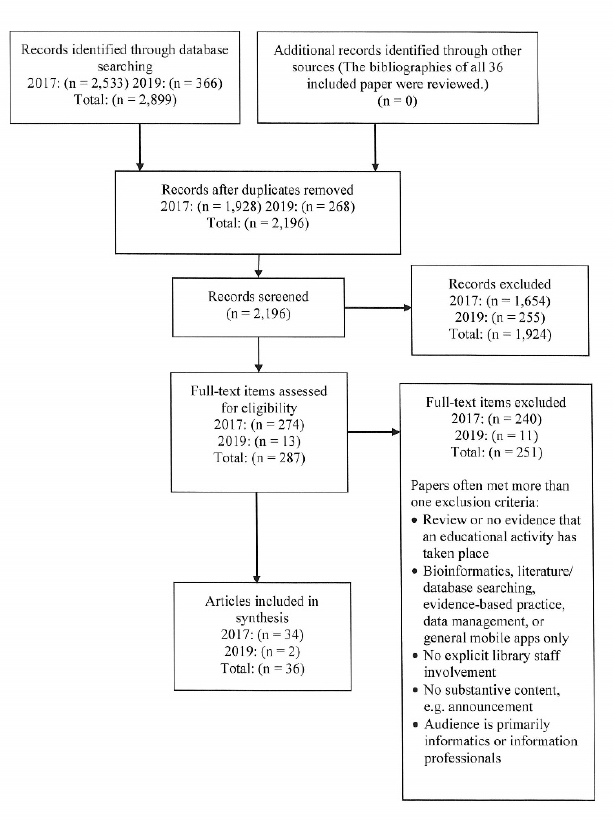
Figure 1 PRISMA Flowchart of literature search and study